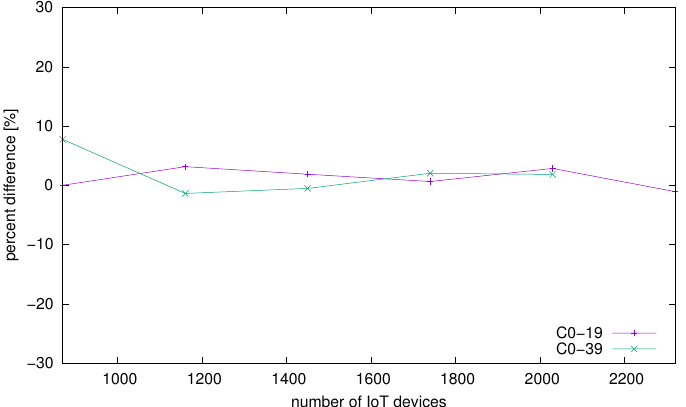
Figure 6. Difference of successfully processed requests—bare-metal and container.